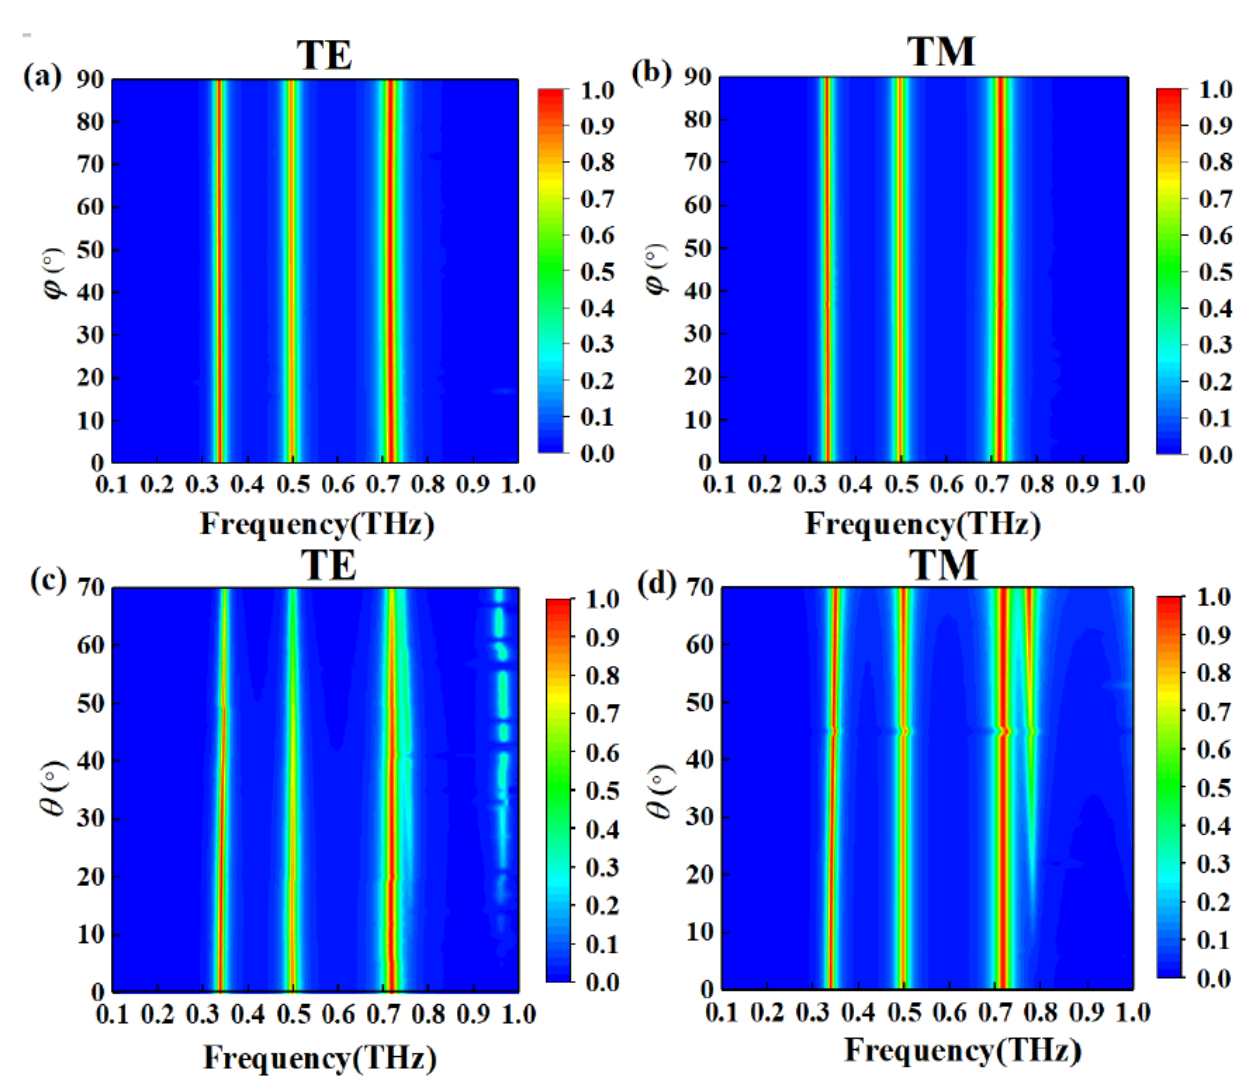
Figure 8. Absorption maps of the absorber under different polarization angles ϕ for ( a ) TE and ( b ) TM polarization; and under different incident angles θ for ( c ) TE and ( d ) TM polarization.